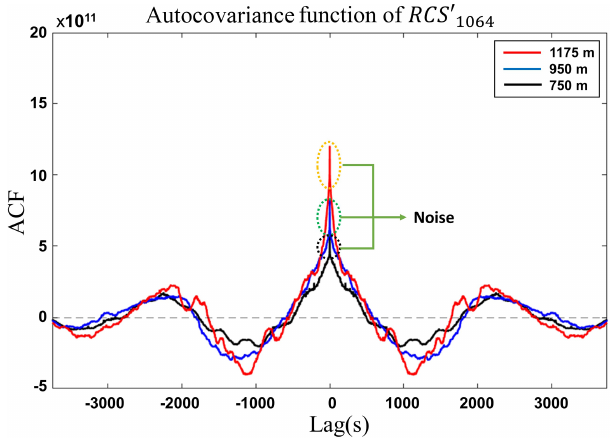
Figure 6. Autocovariance of RCS (cid:48) 1064 obtained from MUL- HACÉN elastic lidar data for three different heights on 19 May 2016 from 12:00–13:00UTC in Granada.